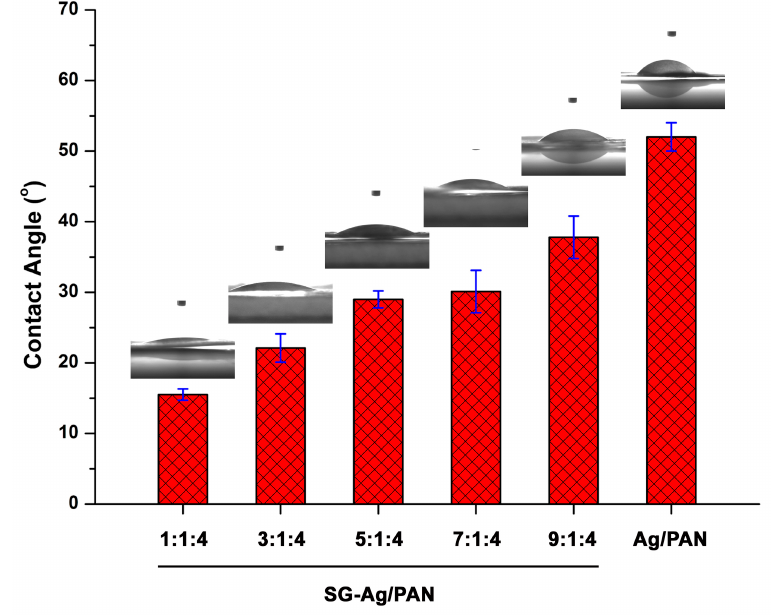
Figure 9. Contact angles of Ag/PAN and SG-Ag/PAN electrospun fibers prepared with different feed ratios of PAN and SG to Ag